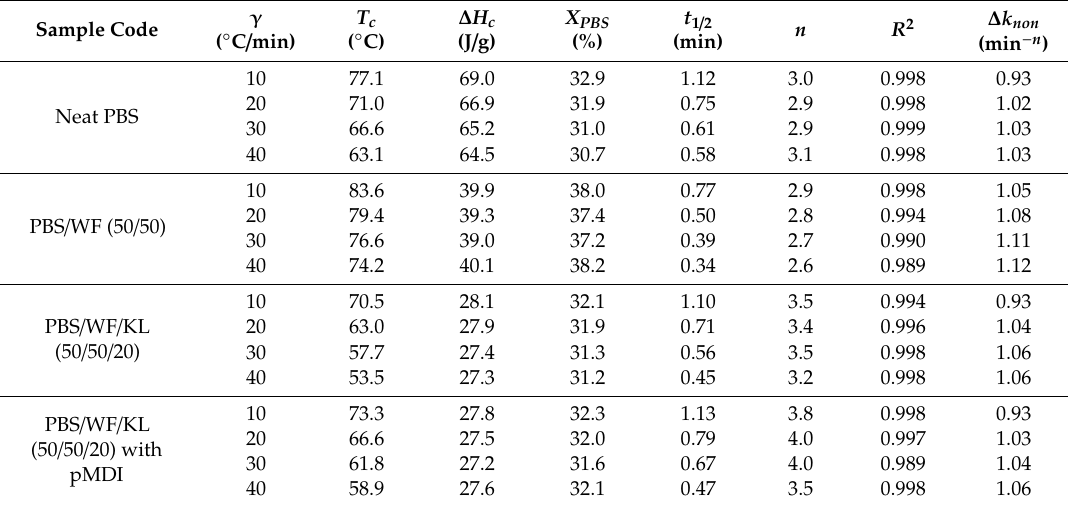
Table 2. Crystallization temperature ( Tc ), crystallization enthalpy ( ∆ H c ), crystallinity of the PBS ( X PBS ), half-crystallization time ( t 1/2 ) , Avrami exponent ( n ), and corrected crystallization rate constant ( ∆ k non ) for the neat PBS, PBS / WF (50 /